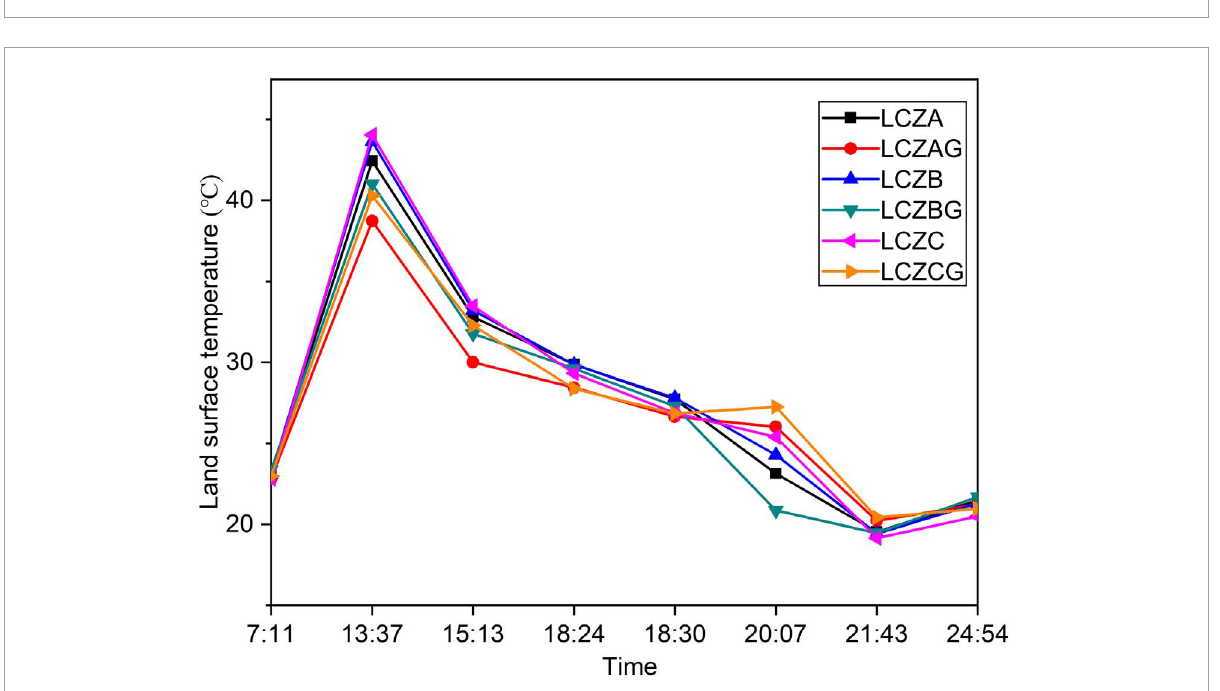
FIGURE6 The mean land surface temperature of parks at different